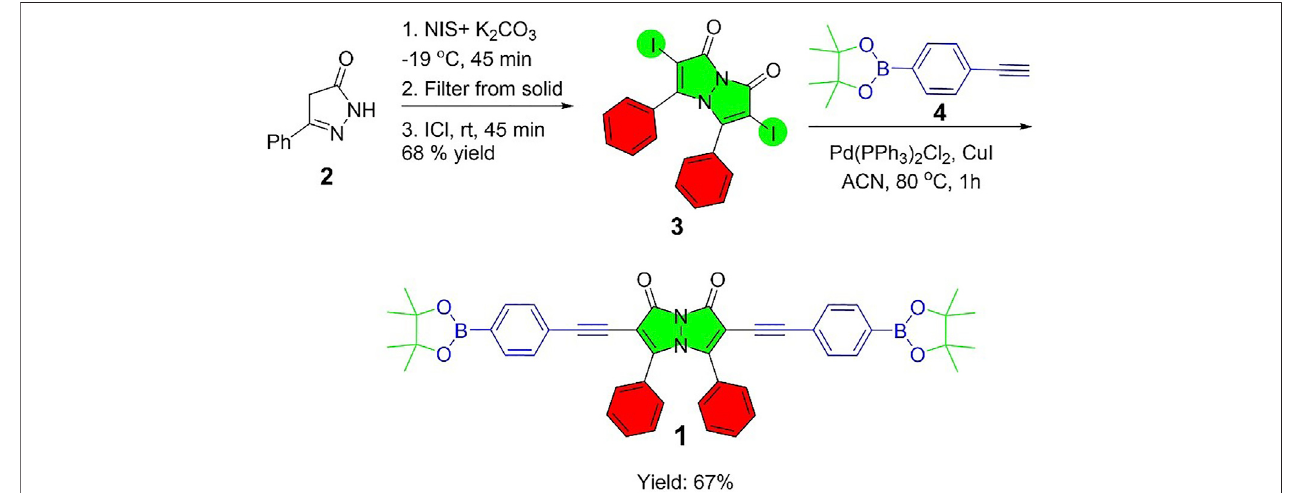
FIGURE 1 | A streamlined synthesis of diboronate ester functionalized bimane 1 .